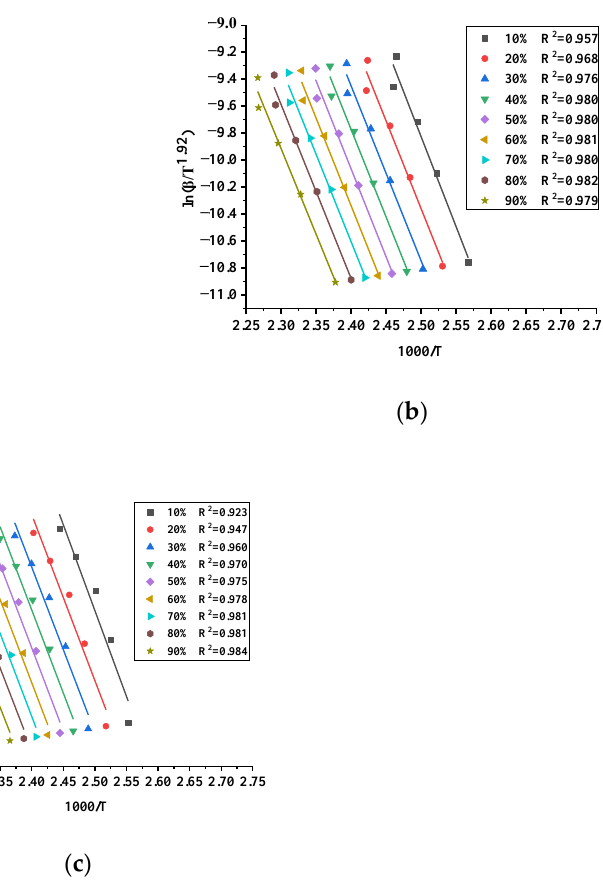
Figure 5. Starink method fitting curve of TBPTMH ( a ) and mixtures with H 2 SO 4 and NaOH ( b , c ).